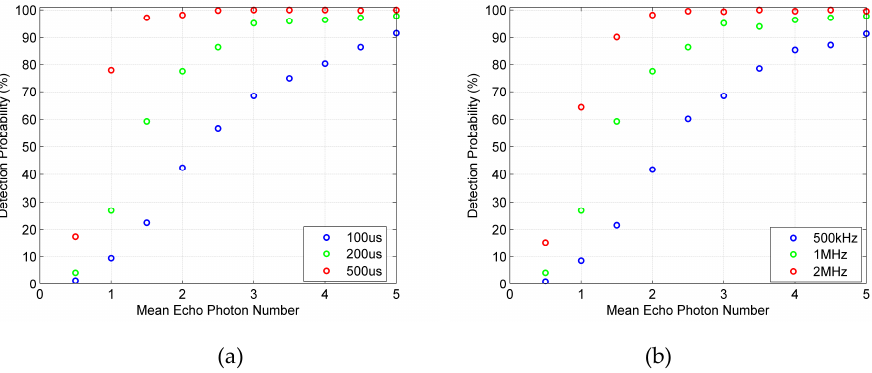
Figure 10. Detection probability of the true random coding photon counting LIDAR. ( a ) Detection probability with di ff erent sequence lengths. ( b ) Detection probability with di ff erent mean pulse count density.